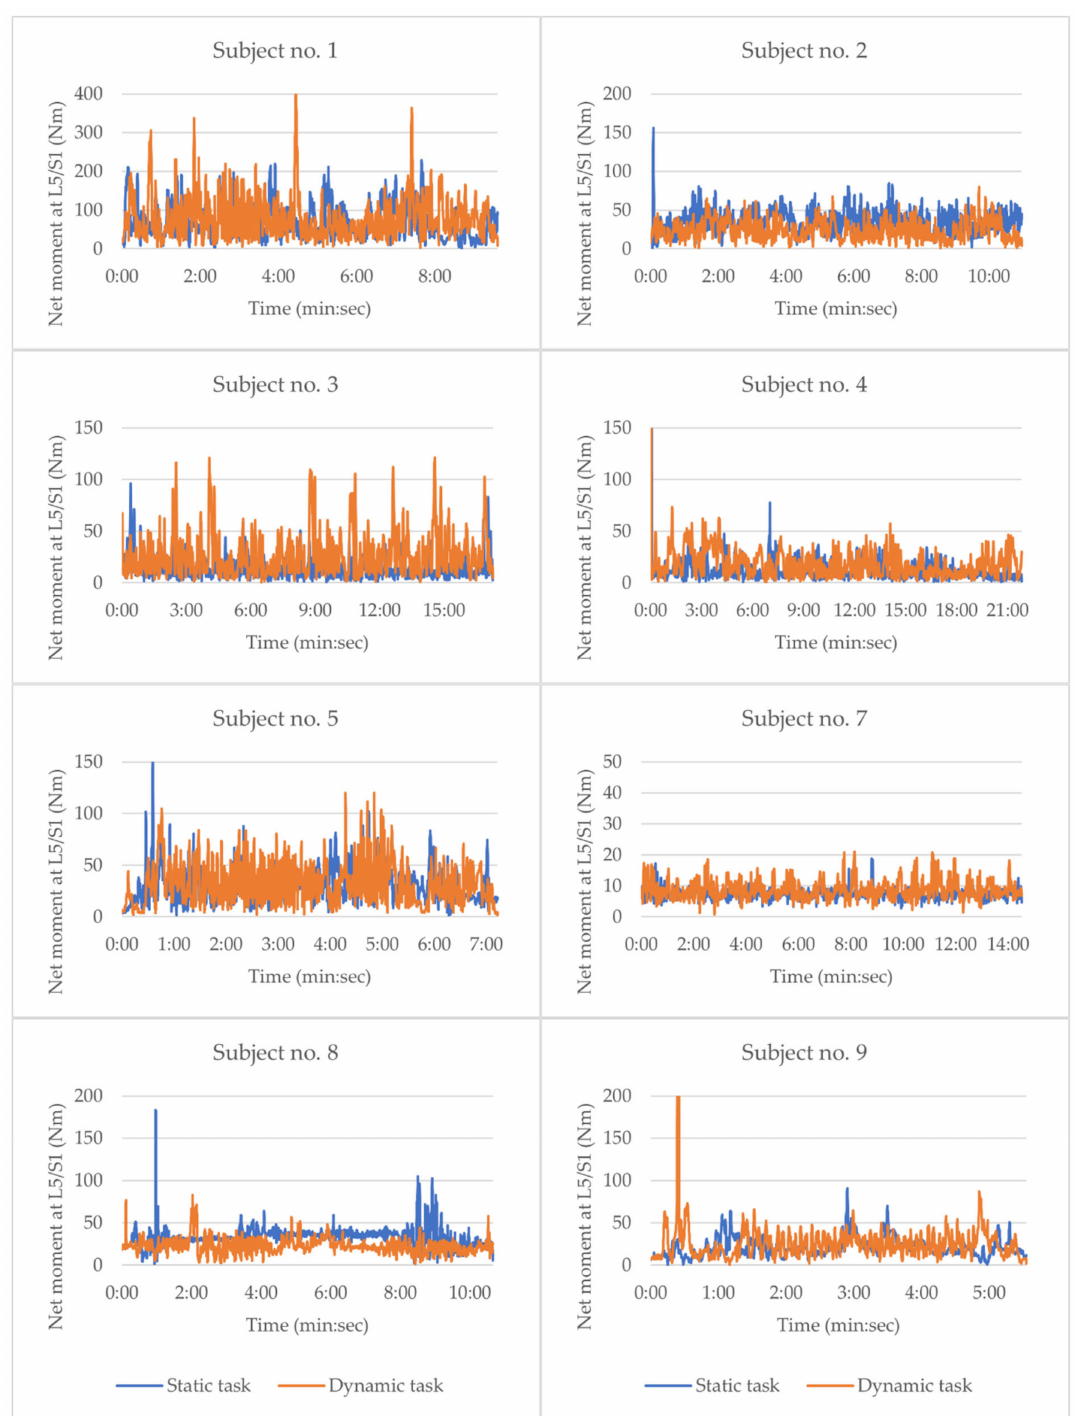
Figure A2. Net moment curves during static (blue) and dynamic (orange)